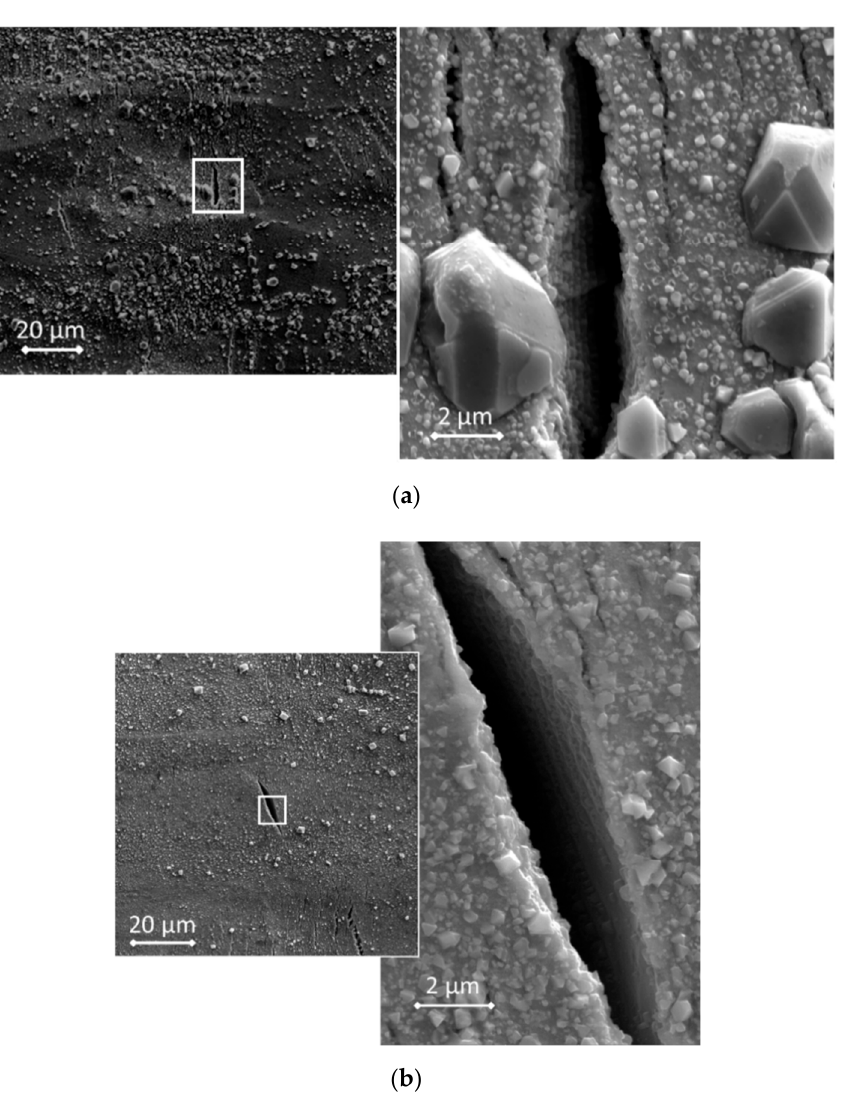
Figure 4. Example of EAC initiation on the surface of solution-annealed Type 316L steel strained (of 1 × 10 − 6 s − 1 in tension in horizontal direction) in HT water (350 °C, LiOH, <20 ppb O 2 , without H 2 addition) [45]. The images show deformation bands, oxide particles, and cracks on the surface, together with zoomed views of boxed area of the following cracks: ( a ) TG cleavage-like (at local plastic strain of 0.12) and ( b ) IG (at 0.10). Note the fine steps lined with fine oxide particles on the internal surfaces of opened cracks.